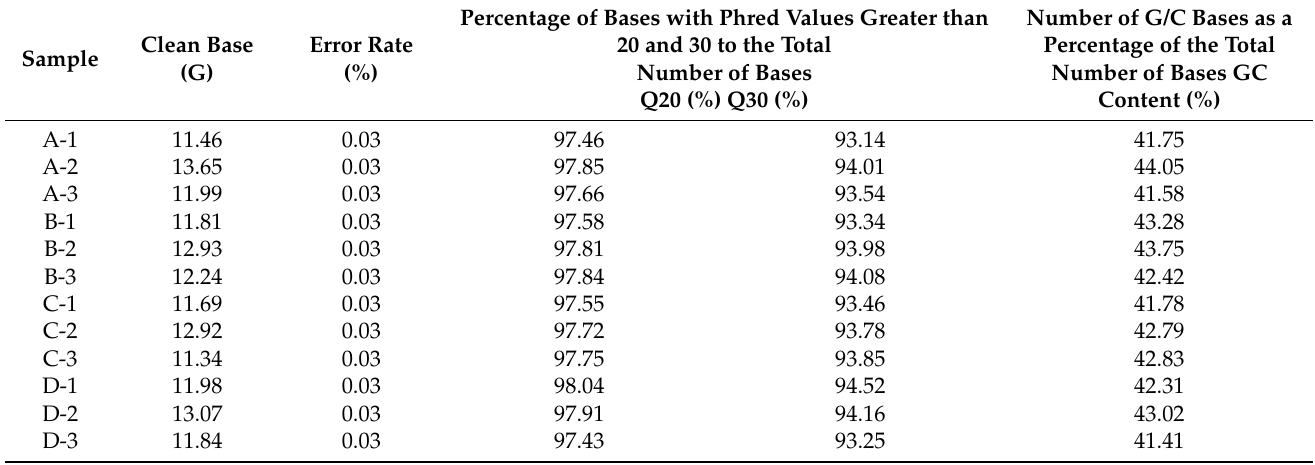
Table 2. Quality summary of sequencing